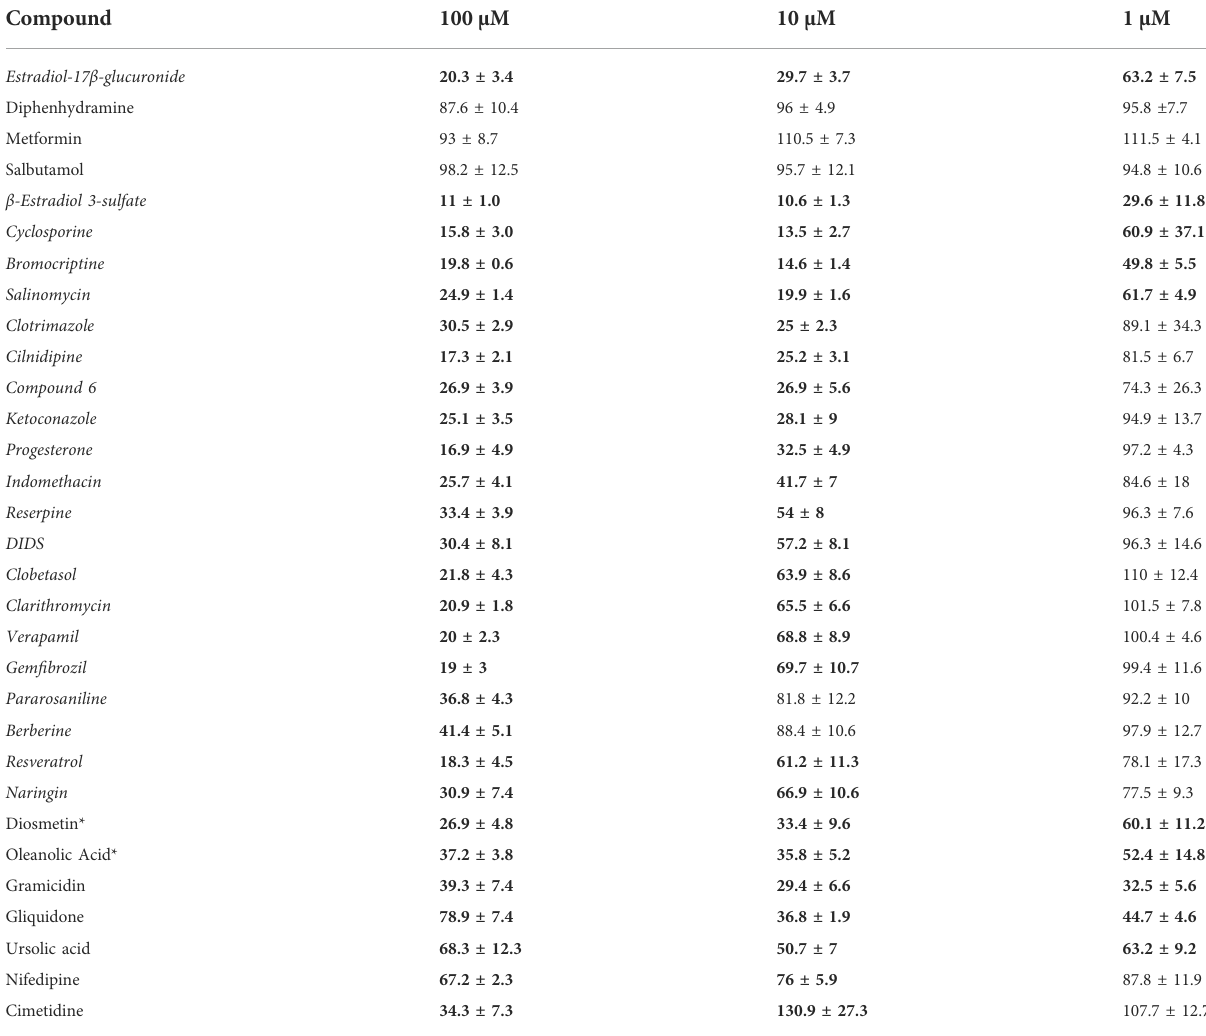
TABLE 1 Concentration-dependent ef fl ux of [ 3 H]-estradiol-17 β -glucuronide from OATP1B1-expressing CHO cells, stimulated by common OATP inhibitors.